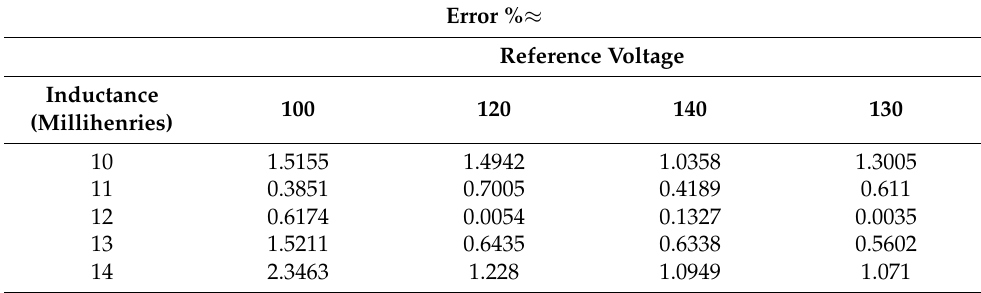
Table 3. Percentage of error in the output voltage due to changes in the